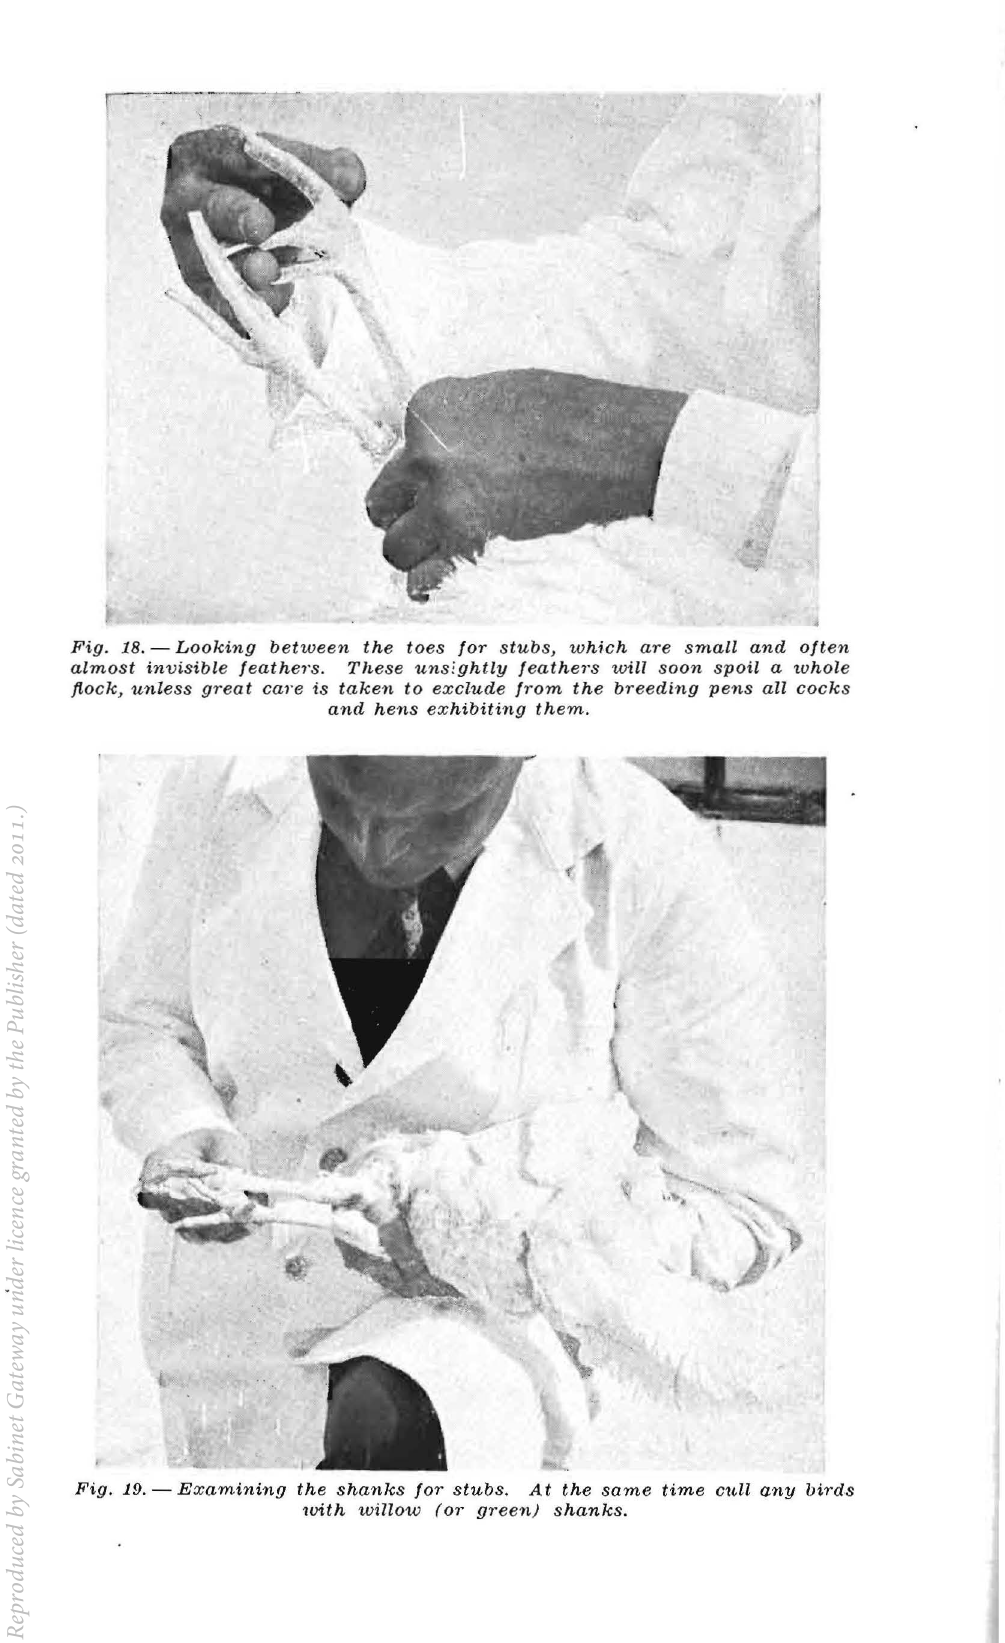
Fig. 19. - E xamining the shanks to,. stubs. At the same time cull any birds with willow (or green)